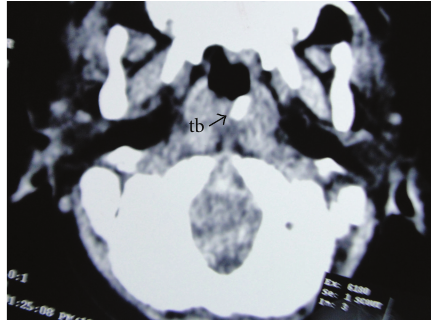
Figure 5: CT scan passing through the atlantooccipital joint, showing the handle of the toothbrush (tb) coming out to the surface from the retropharyngeal space of the nasopharynx.